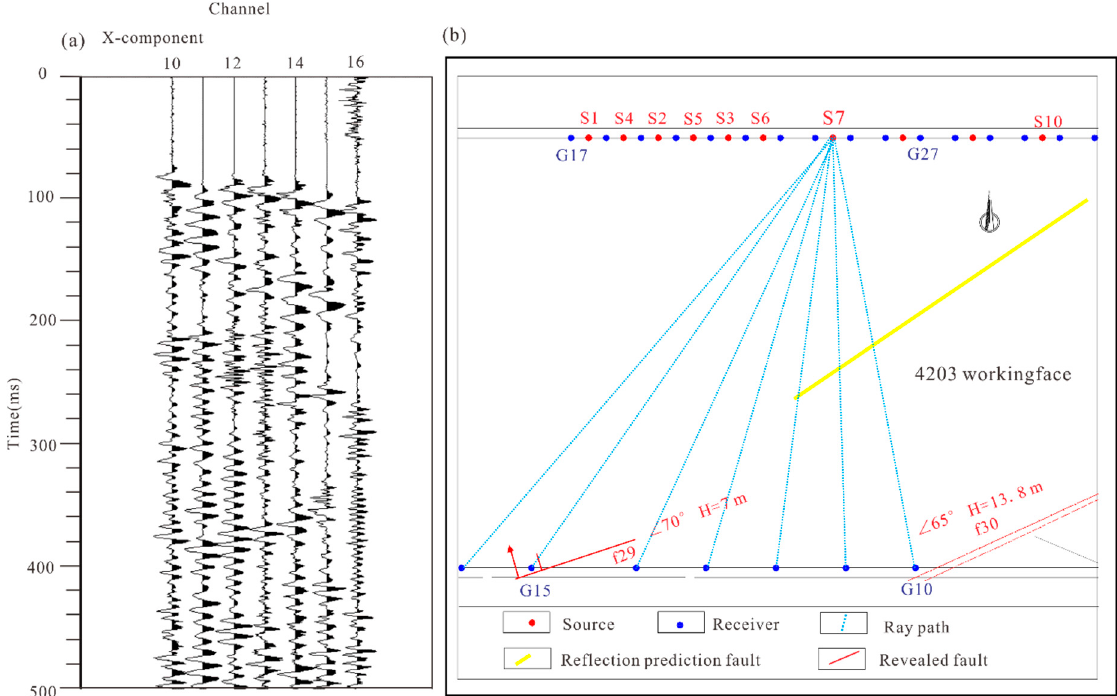
Figure 5. ( a ) S7 transmission record; ( b ) ray path.